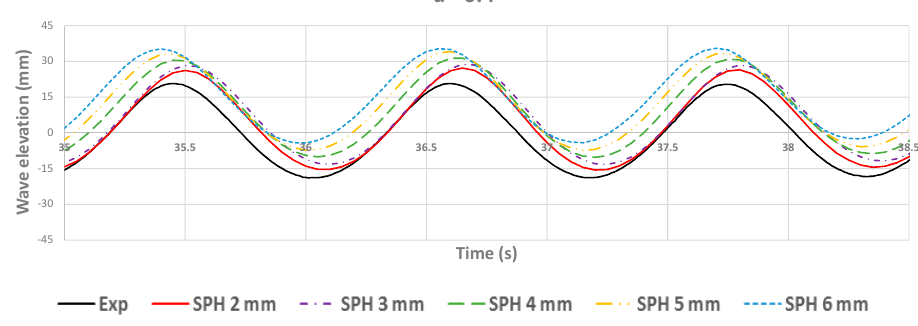
Figure 8. Grid study for T = 1.15 s, A = 16.5 mm and d = 0.4 m. Table 5. Particle spacing and total particles for grid study.